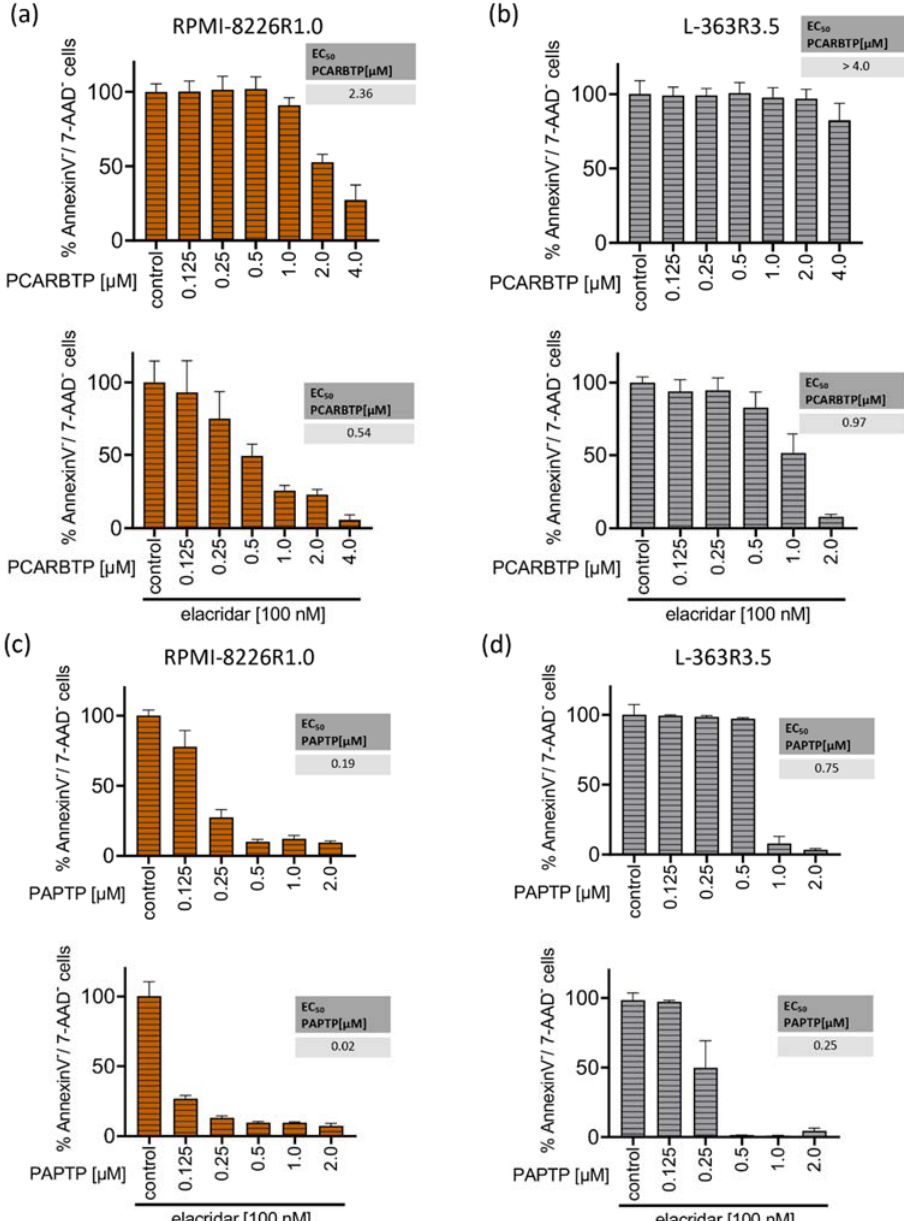
Figure 4. Resistance to PCARBTP is mediated by MDR-1, RPMI-8226-R1.0 and L-363-R3.5 are cross-resistant to PAPTP. ( a , b ) Parental L-363 and RPMI-8226 multiple myeloma cells and PCARBTP- resistant L-363-R3.5 and RPMI-8226-R1.0 cell lines were incubated with PCARBTP or 0.1% DMSO control in the presence or absence of elacridar as indicated. After 24 h, cell death was determined by flow cytometry with Annexin V-APC/7AAD-staining. Resistant RPMI-8226-R1.0 ( c ) and L-363- R3.5 cells ( d ) were treated with increasing concentrations PAPTP ± 100 nM elacridar for 24 h. After 24 h, cell death was determined by flow cytometry with Annexin V-APC/7AAD-staining. Values are normalized to solvent-treated control. Shown is the mean ± SD, ( n = 3 independent experiments, each in duplicate).